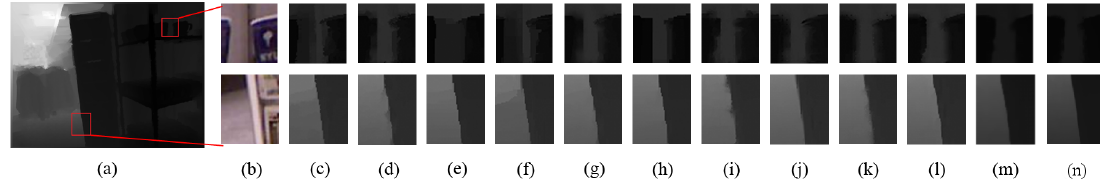
Figure 14. Example depth map SR results of Store1 with two ROI. ( a ) Ground truth depth map, ( b ) color regions, and SR results of ( c ) Diebel et al. [22] (BP% = 3.09) , ( d ) JBU [11] (3.60) , ( e ) Lu et al. [23] (2.56)